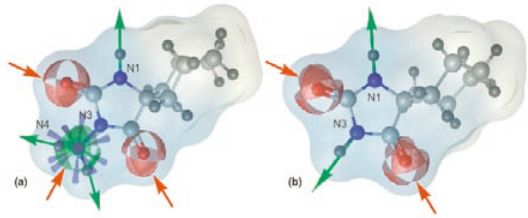
Figure 4. Hydrogen bonding sites and direction in (a) 3-amino-cycloheptanespiro-4’-imidazolidine-2’,5’-dione (IA) and (b) cycloheptanespiro-4’-imidazolidine-2’,5’-dione [8]; possible acceptors are denoted with red and donors with green arrows. Map colour coding of this figure indicates hydrophilic area with blue and hydrophobic space with